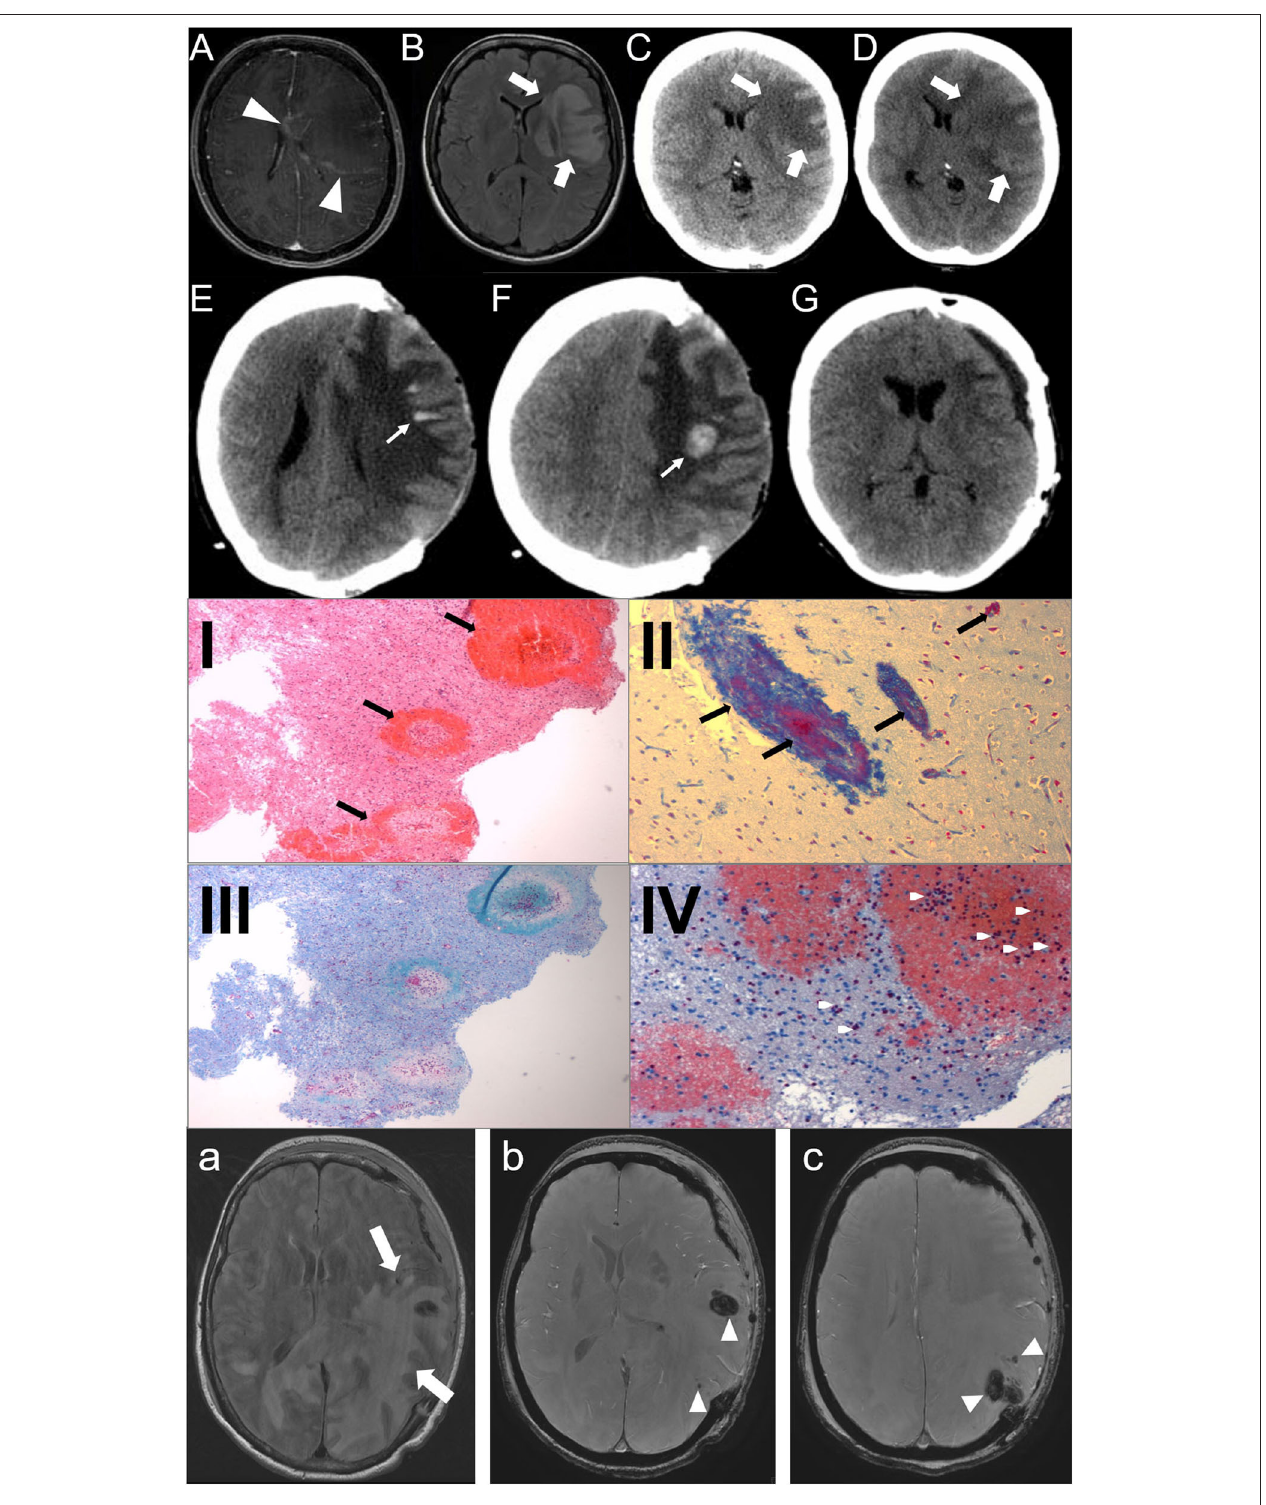
FIGURE 1 | (A–G) : Case 1: Day 1: axial MRI, T1-weighted with contrast (A) , FLAIR-sequence (B) , CT-scan (C) show a left frontal white matter lesion (big arrows) with rim contrast enhancement (arrowheads) and midline shift; Day 2 (D) : CT-scan: progressive edema; Day 15 (E,F) : CT-scan: bleedings (small arrows); Day 80 (G) : reimplantation of bone plate. (I–IV) : Histopathology of the brain biopsy (Case 1). Multiple perivascular bleedings [ (I) , HE-stain], fibrin accumulation [ (II) , Ladewig-stain], demyelinization [ (III) , LFB-PAS] and granulocystic infiltration [ (IV) , Chloracetatesterase]. (a–c) : Case 2: Day 3: axial MRI, FLAIR-sequence (a) shows a subcortical left temporooccipital white matter lesion (big arrows) with midline shift and multiple hemorrhages (arrowheads) in SWAN-sequence (b,c) .